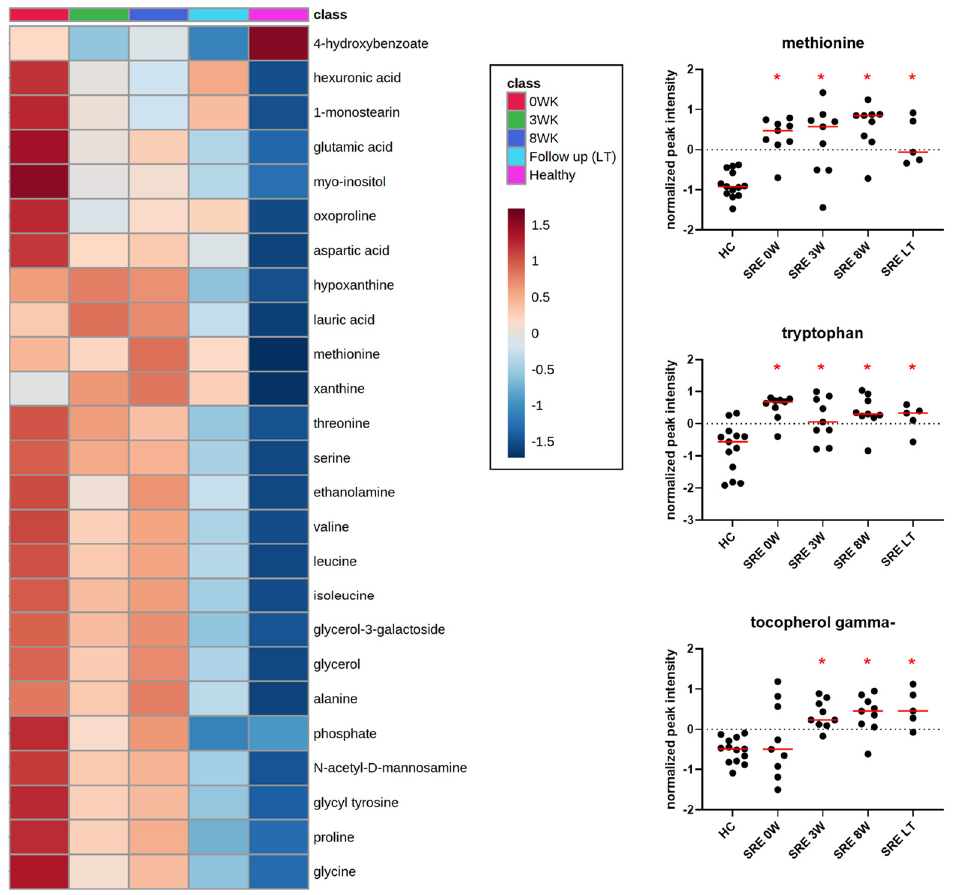
Figure 5. Heatmap of top 25 metabolites (one-way ANOVA adjusted for multiple comparisons) identified in fecal samples ( left ), and relative abundances of methionine, tryptophan, and tocopherol gamma (vitamin E) in HC, and in dogs with SRE over time ( right ). Red asterisks indicate statistical significance (q < 0.05) compared to healthy controls. Note that methionine and tryptophan were significantly increased at baseline and remained increased after 1 year from the beginning of treatment, while tocopherol gamma only increased after the beginning of treatment, and remained increased despite the discontinuation of treatment after 8 weeks. Table 3. Selected fecal metabolites identified by untargeted metabolomics that were significantly different in dogs with SRE (complete list available in Table S3). Compound type, direction of change compared to healthy controls (HC), as well as the time points at which changes were statistically significant are indicated, as well as overall p -values and adjusted p -values (FDR). NIST = National Institute of Standards and Technology.